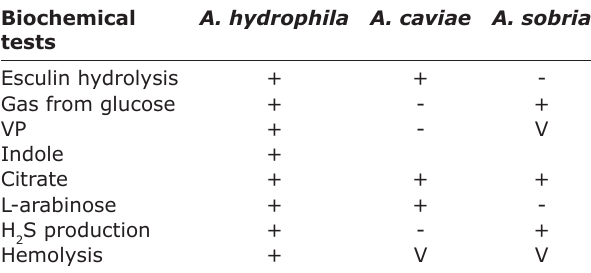
Table-1: Biochemical characteristics of different Aeromonas spp. [6].